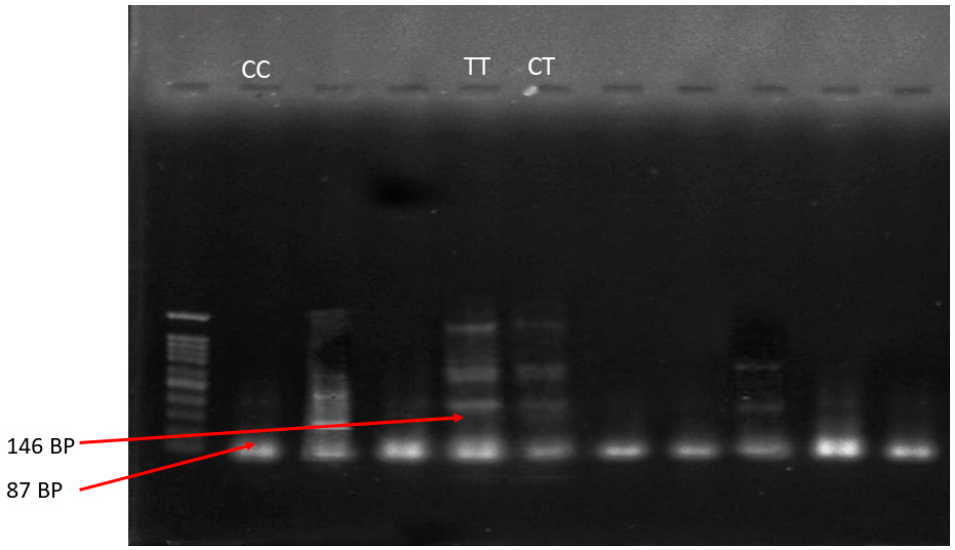
Figure 2. Agarose gel electropherogram of MTHFR (rs1801133), or genotype (CC, TT, and CT) performed by Tetra-ARMS PCR.